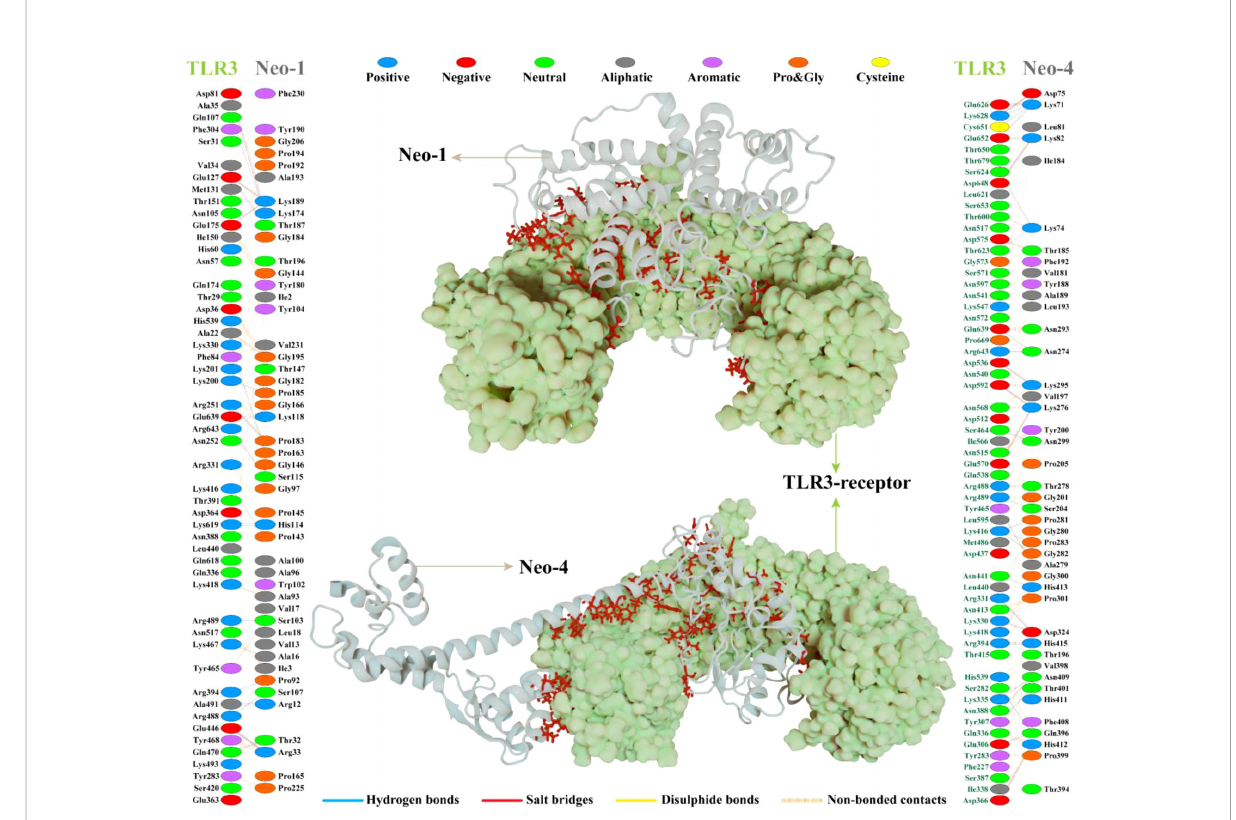
FIGURE 5 NeoCoV vaccine constructs (Neo-1 and Neo-4) docked with human Toll-like receptor-3 (TLR3). The best-docked vaccine-TLR3complex is depicted in the middle. Neo-1 and Neo-4 are represented with a silver cartoon model, and TLR3 is shown in a light green surface model. The interacting residues of Neo-1 and Neo-4 with TLR3 receptor are shown on either side. Hydrogen bonds are indicated in blue lines. The color of interacting residues re fl ects the properties of amino